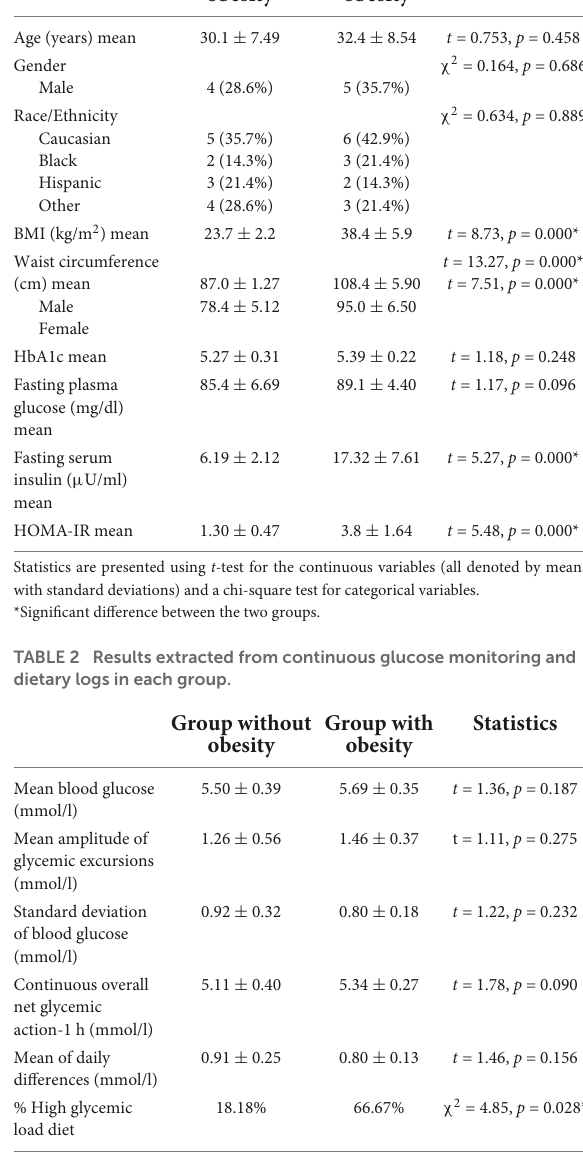
TABLE 1 Baseline demographic and clinical characteristics of the participants in each group. Group without Group with obesity obesity